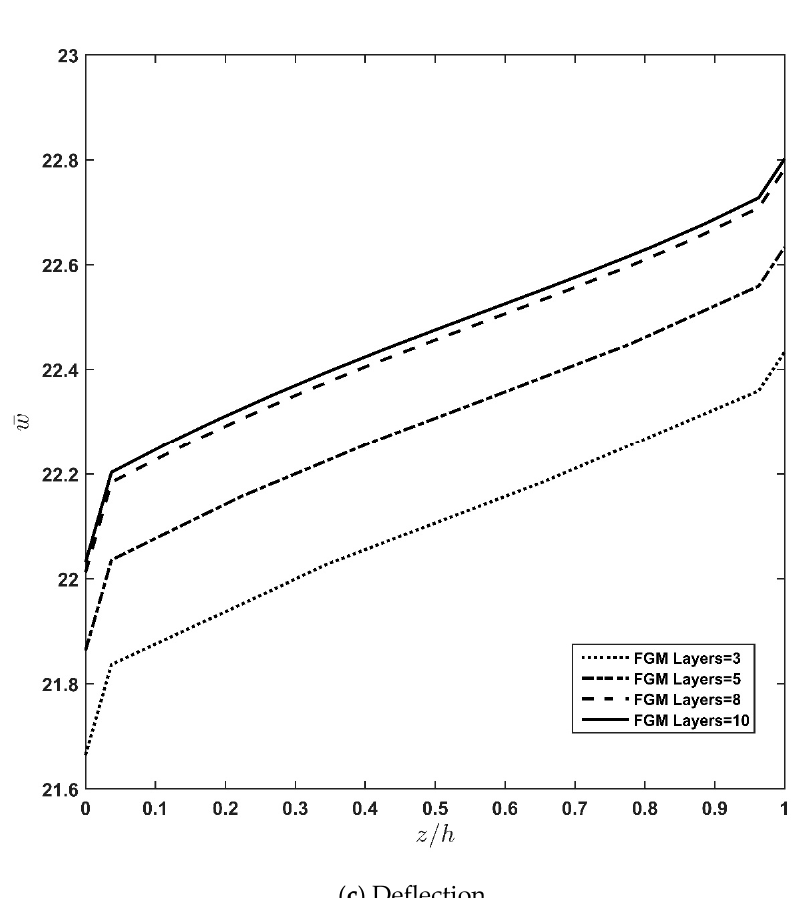
Figure 3. Effect of fictitious layer number of FGM layer on through-thickness distribution of dimen- sionless normal and shear stresses and deformation for the FG